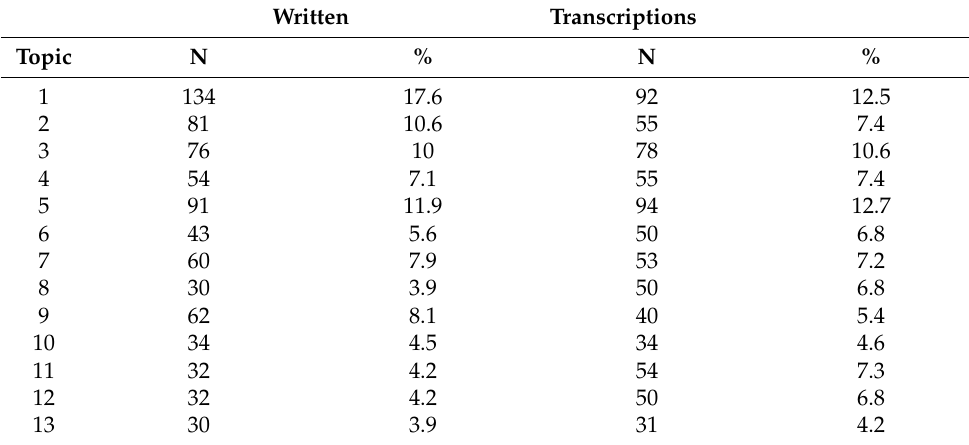
Table 1. List of topics: (1) Vaccinations should/should not be compulsory; (2) Polish energy should be based mainly on coal/renewable and non-emission sources; (3) People should/should not eat meat; (4) Smartphones and social media positively/negatively affect interpersonal